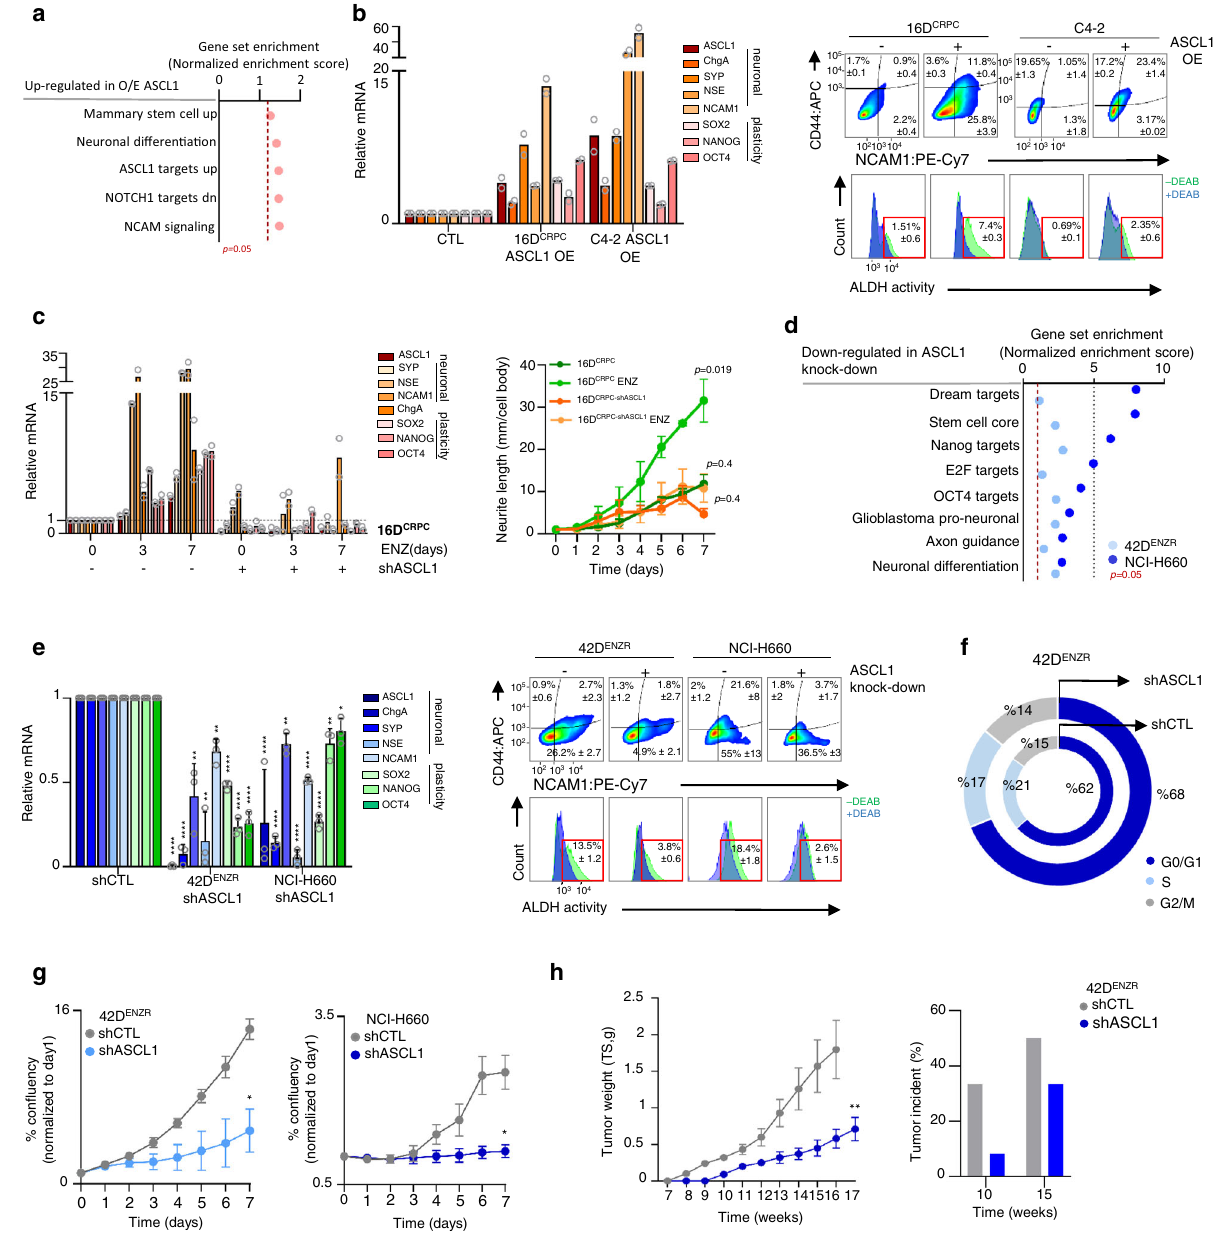
overlap which were lost after ASCL1 knockdown (Fig. 5d), were the number of H3K27me3 peaks went from 43,622 in control to 10,336 in knockdown ASCL1 (Supplementary Fig. 5i). Regions co-bound by ASCL1 and H3K27me3 were enriched with ASCL1 motif (Supplementary Fig. 5j). Of note, within same region DNA binding motif of TF OCT was enriched. This region was enriched for PRC2 targets as well as basal/luminal phenotype (Fig. 5g). Visualization of genomic loci of TMPRSS2 and ALDH1A3 , genes correlating with luminal phenotype in prostate cancer 29,30 , showed co-occupation of ASCL1 and H3k27me3 on promoter and gene body (Supplementary Fig. 5k). we performed ChIPseq for EZH2 in 42D ENZR cell line following knockdown of ASCL1. Unexpectedly, comparative analysis between control and ASCL1 silencing condition revealed a signi fi cant loss of EZH2 binding to chromatin (36,139 peaks